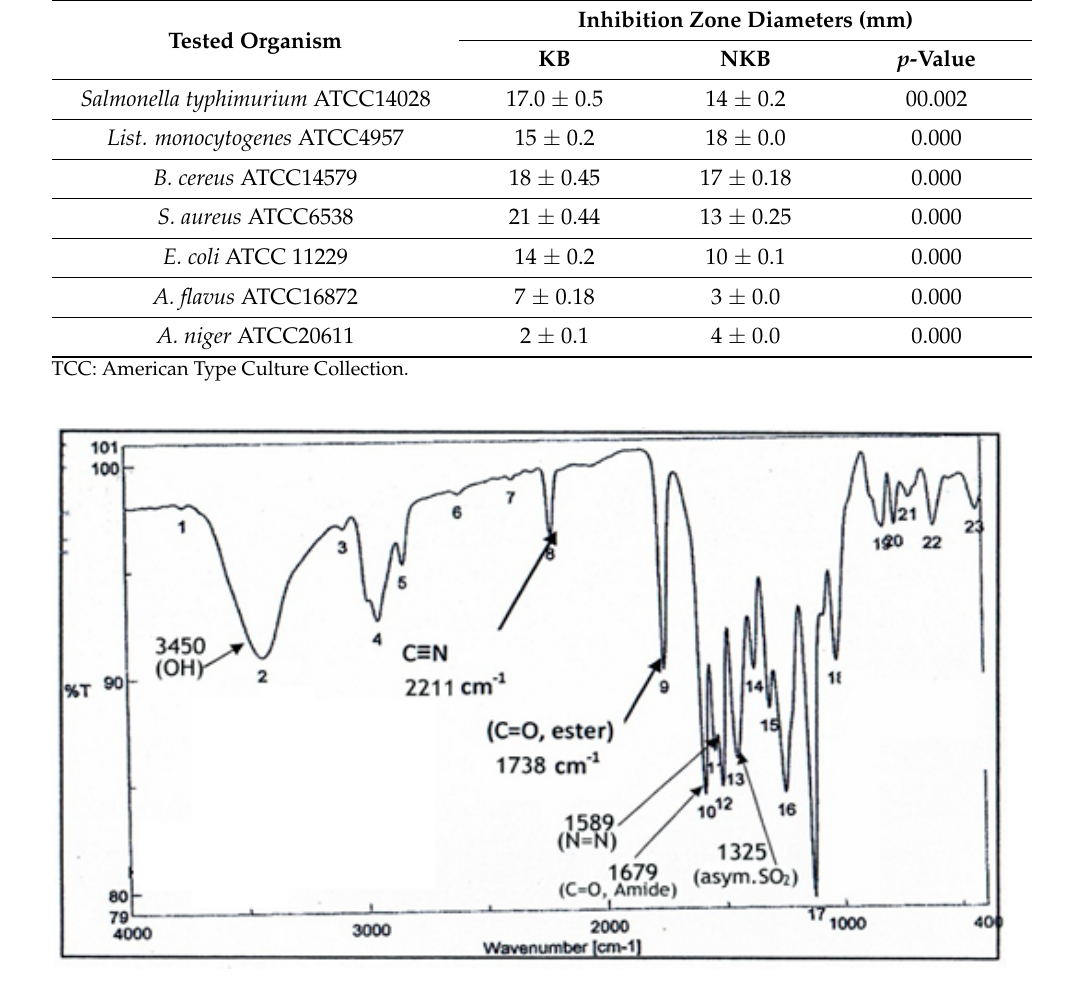
Figure 2. IR spectrum in KBr (discs) for the extraction of KB.